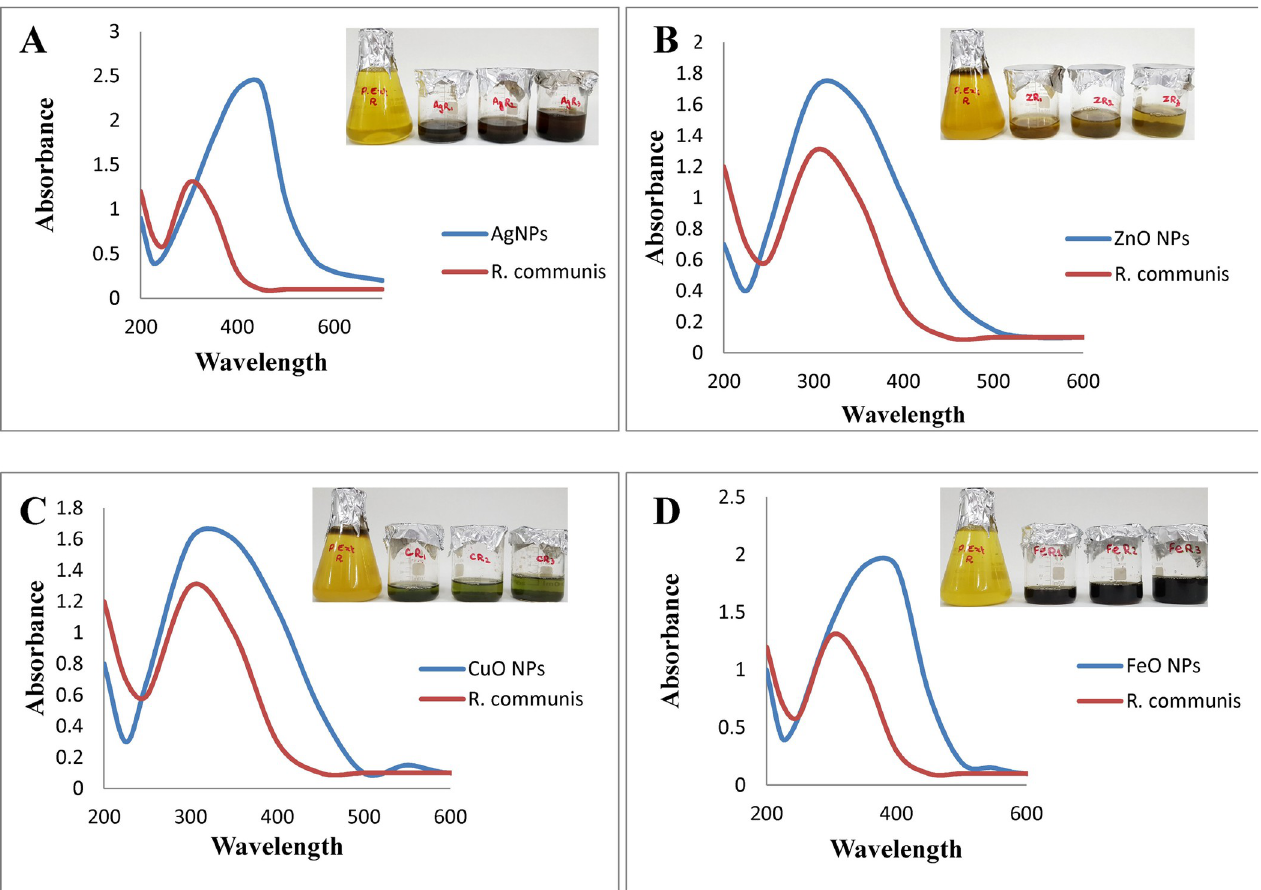
Fig 1. UV–Vis spectrum of R . communis and (A) AgNPs (B) ZnO NPs (C) CuO NPs and (D) FeO NPs, synthesized by using 10 mL of 2 mM salt solution with 30 mL of plant extract.